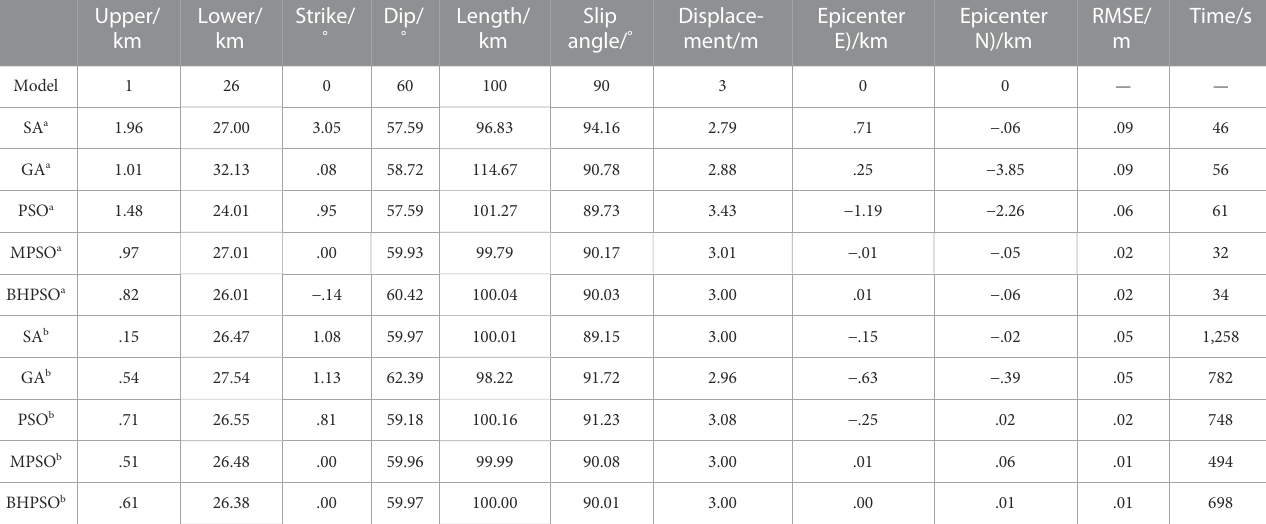
TABLE 2 Parameter settings of simulated dip-slip fault earthquake and inversion results of different methods. Upper/ km